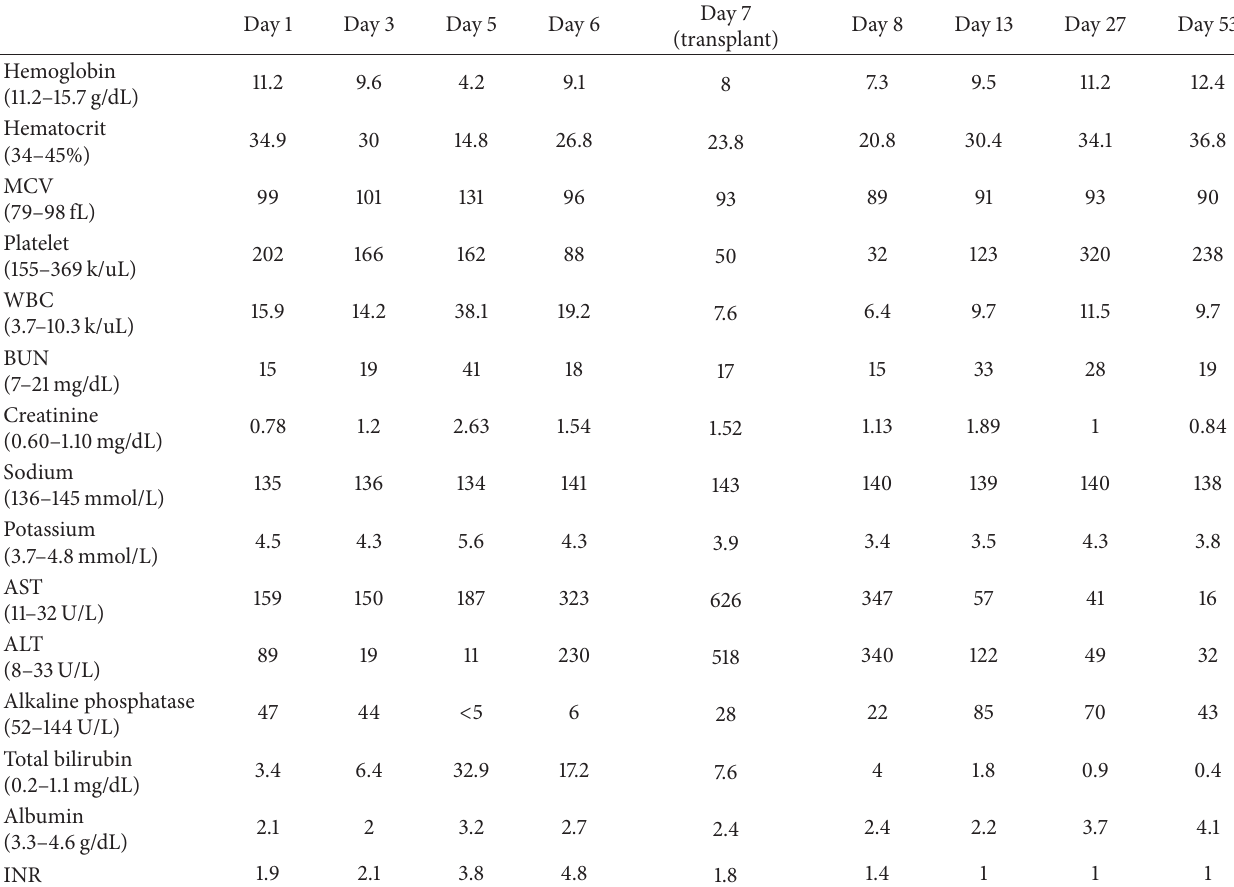
Table 1: Trend of laboratory values before and after liver